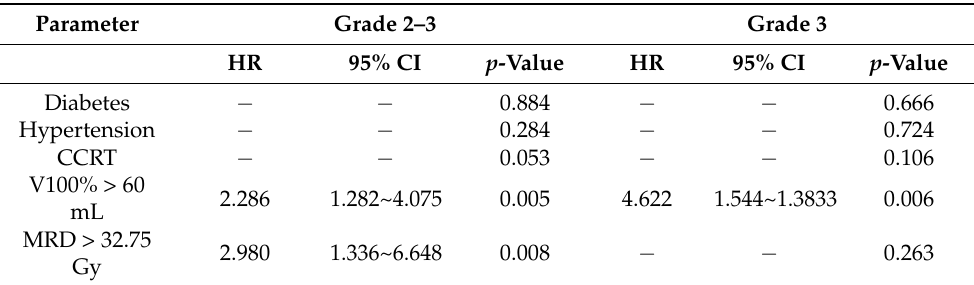
Table 4. Multivariate analyses for Grade 2–3 diarrhea.